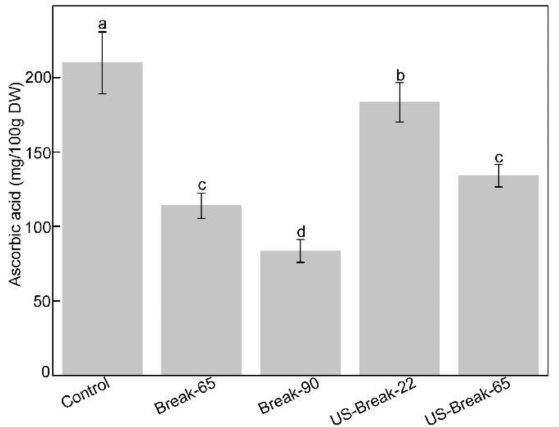
Figure 6. Effects of different breaking treatments on the content of ascorbic acid in tomato juices and pastes. Control refers to the untreated raw tomato juice. Break-65, Break-90, US-Break-22 and US- Break-65 refer to the thermal break at 65 ◦ C for 10 min, thermal break at 90 ◦ C for 10 min, ultrasound break at 22 ◦ C for 10 min, and ultrasound break at 65 ◦ C for 10 min, respectively. a–d Data bearing different lowercase letters were significantly different ( p <